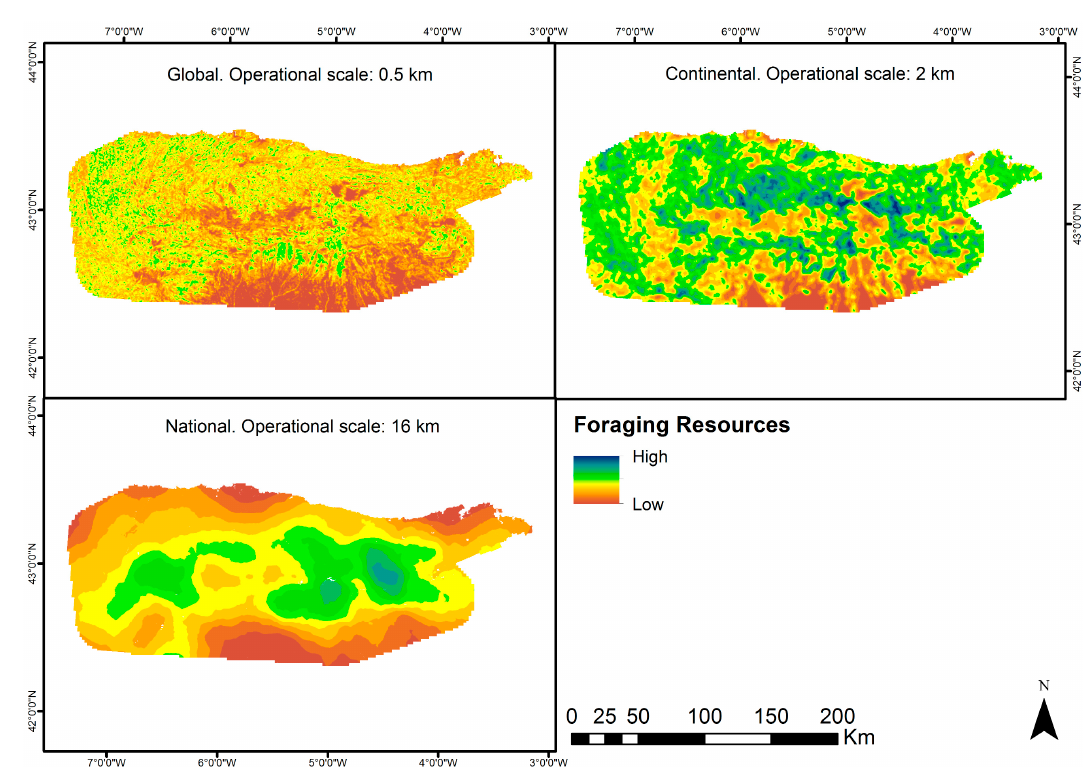
Figure A1. Operational scales of the foraging resources variable for the three datasets.